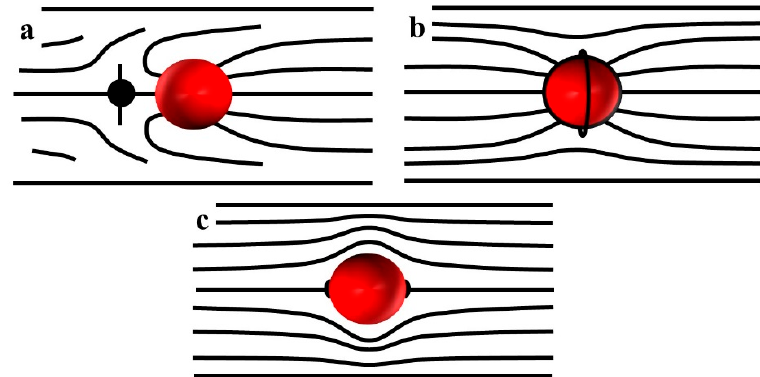
Figure 2. Director configurations around colloidal particles in a uniform nematic. ( a ) Dipolar structure with a hyperbolic point defect-hedgehog on the left hand side of a sphere with normal surface anchoring; ( b ) Quadrupolar structure with an equatorial director field around a sphere with normal anchoring in a shallow nematic cell; ( c ) Quadrupolar deformations around a tangentially anchored sphere with two point defects-boojums at the poles.